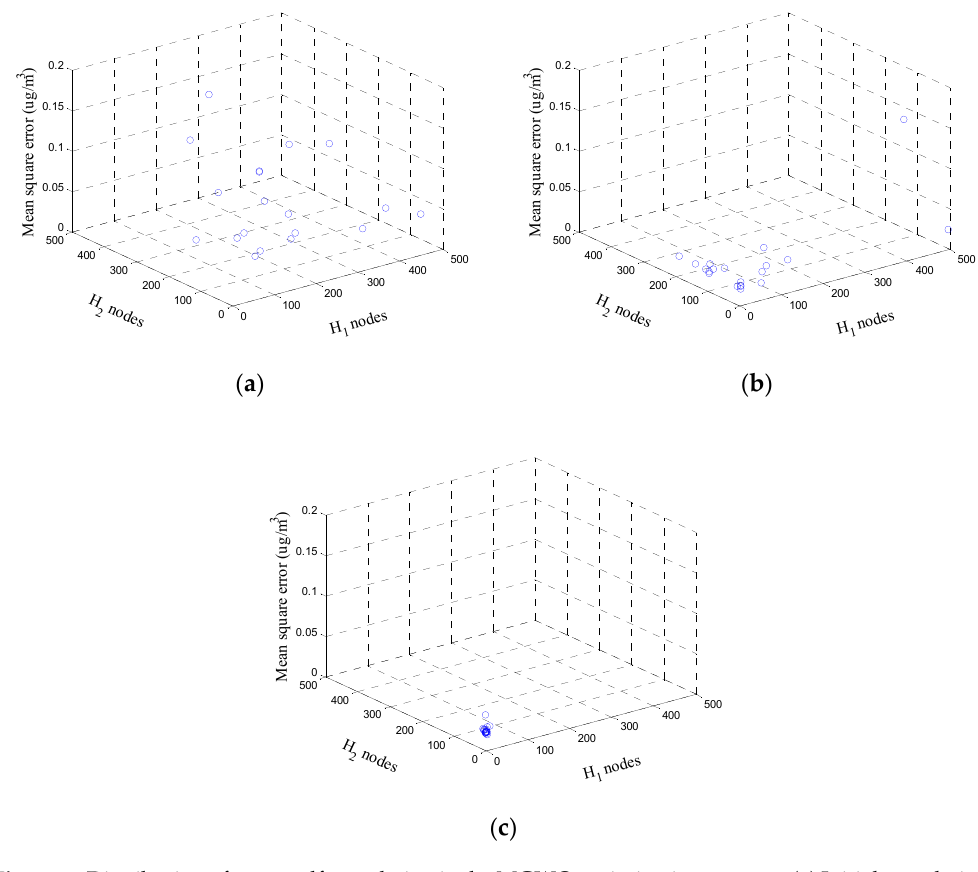
Figure 5. Distribution of grey wolf population in the MGWO optimization process. ( a ) Initial population. ( b ) The fourth-generation population. ( c ) The eighth-generation population.